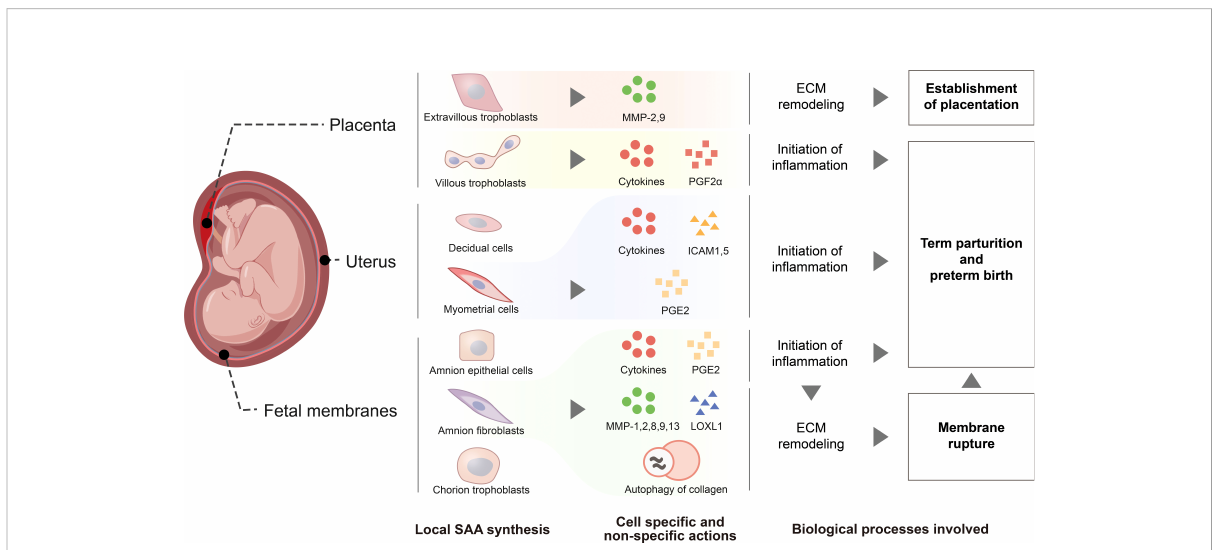
FIGURE 3 Schematic drawing depictingfunctions of SAAsynthesized within gestational tissues. De novo SAA synthesis is detected in extravillous trophoblasts and syncytiotrophoblastsof the placenta, myometrial and decidual cells ofthe uterus, epithelial and fi broblast cells ofthe amnion, cytotrophoblastsof the chorionic membrane.In extravilloustrophoblasts, SAA may promote their invasion into the endometrium throughinductionof metalloproteases 2 and 9 for the establishment of placentation. SAA synthesized within myometrium, placenta and fetal membranes may promote parturition via enhancing in fl ammatory reactions throughinduction ofpro-in fl ammatorycytokines and other in fl ammatory mediatorsincluding prostaglandins PGF2 a and PGE2, ICAM1and ICAM5, the adhesionmolecules for the in fi ltrated leukocytes. Moreover, SAAmay also facilitate fetal membrane rupturein parturition throughinduction ofextracellular matrix remodeling via increasing the expressionof metalloproteases 1,2,8,9 and 13, decreasing the expression of lysyloxidase ‐ like 1 and inducing autophagy-mediated collagen